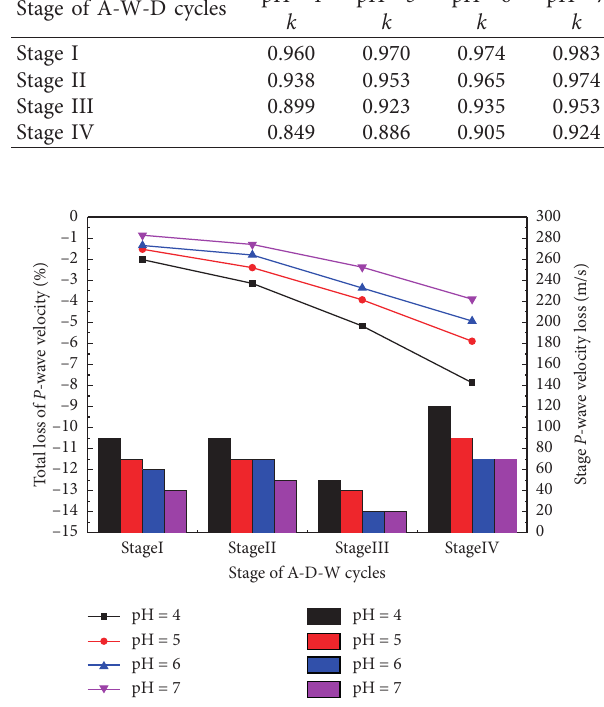
Figure 8: Changes of average P -wave velocity loss of specimens versus solution pH and A-D-W